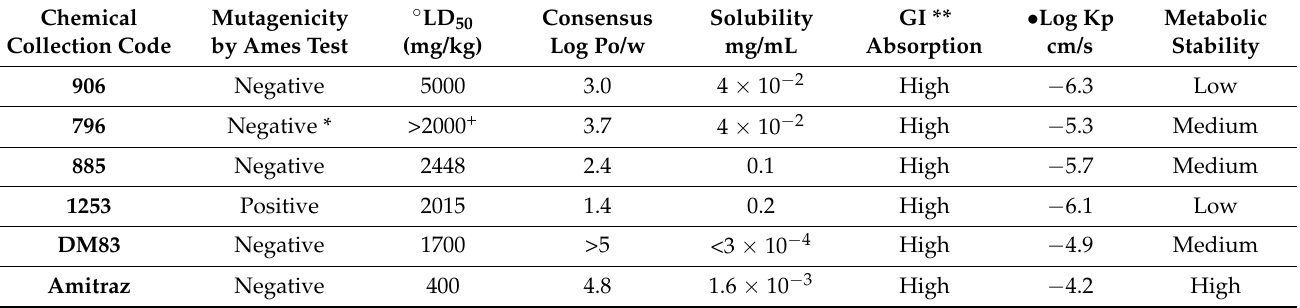
Table 5. Toxicity and pharmacokinetic profile of compounds with the best acaricidal